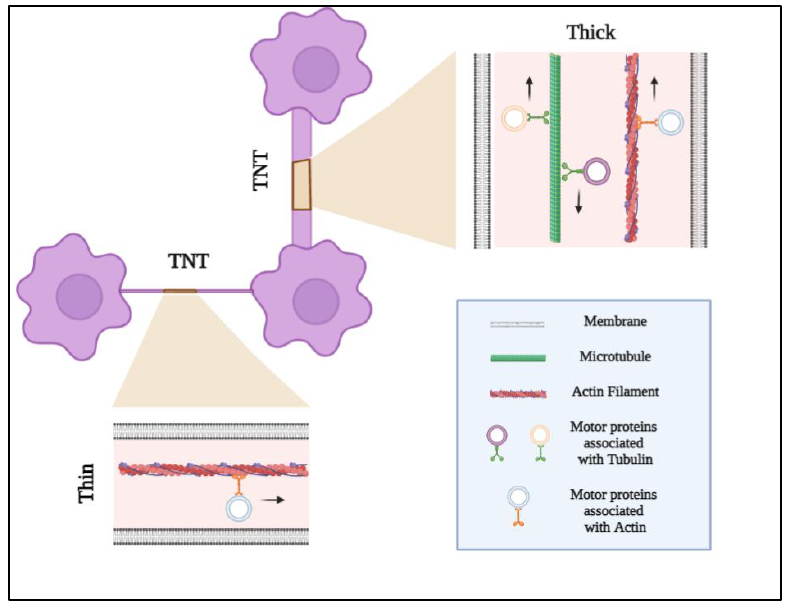
Figure 1. Tunneling nanotube (TNT) structures. TNTs are heterogeneous, transient, and highly dynamic nanotubular structures that connect cells over short or long distances. TNTs can be classified as two types: (1) short (100–200 nm), thin ( ≤ 0.7 µ m), and dynamic type I nanotubes are made of actin and formed by cells exploring their surroundings to make cell–cell contact; (2) long (1 µ m), thick ( ≥ 0.7 µ m), and more stable type II nanotubes are made of tubulin and actin filaments. TNTs transport cellular organelles such as mitochondria and lysosomes, as well as viruses, intra-cellular vesicles, and electrical signals. The mechanism of cargo transport can be unidirectional or bidirectional. Type I nanotubes (actin-based) are characterized by a unidirectional transport mechanism in which cellular components are anchored and driven by the directional actin polymerization at one end. The hallmark of type II nanotubes is bidirectional delivery, in which cargo is moved by microtubule-based molecular motor proteins.